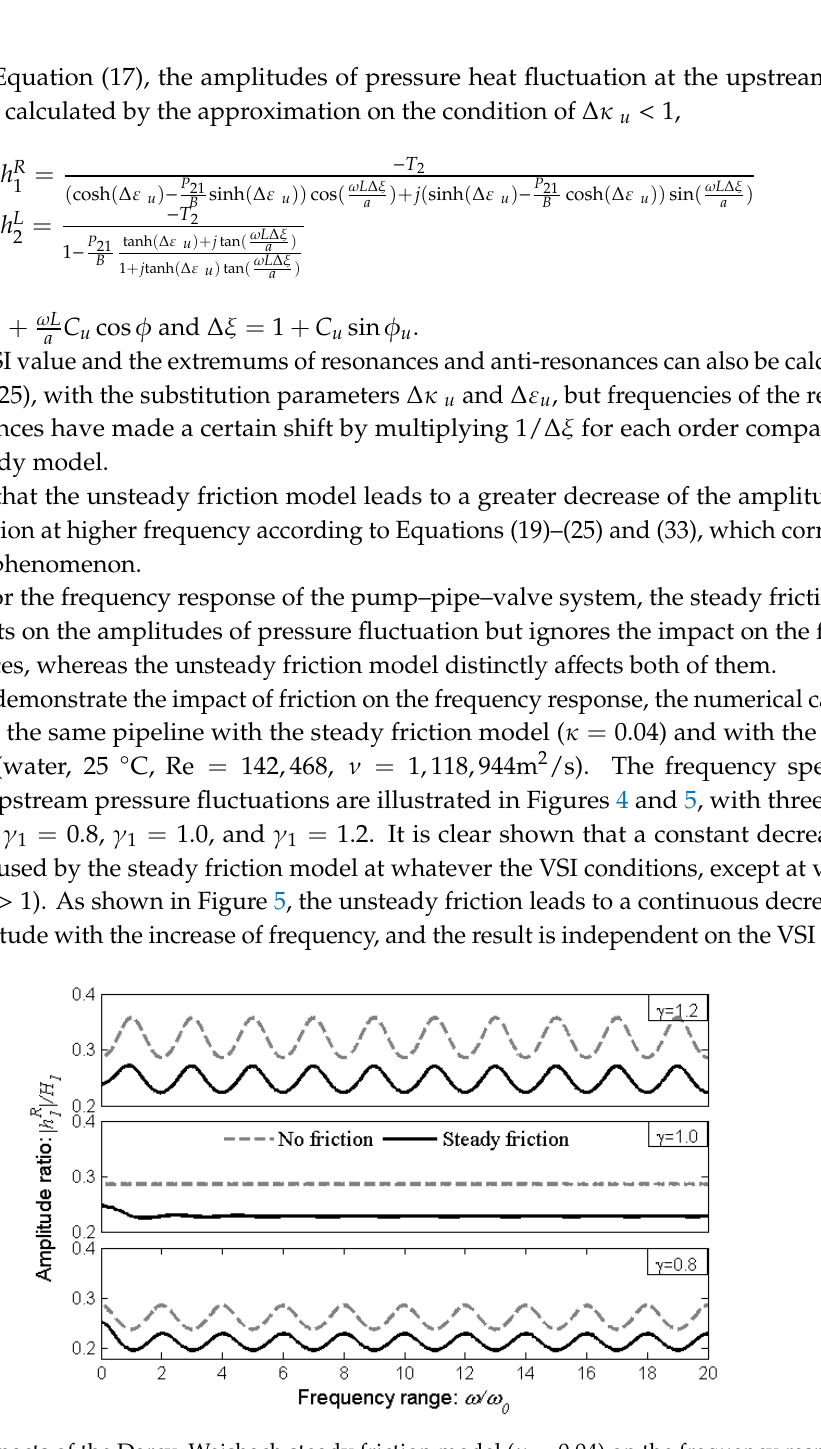
Figure 5. Impacts of the unsteady friction model ( Re=142,468 ) on the frequency response with three VSI conditions. The amplitudes of upstream pressure fluctuation in Figures 4 and 5 are obtained by the actual frequency response (Equation (16)). Errors of extremums between the approximation and the actual values are also considered. The approximation error can be calculated by 1 1max max